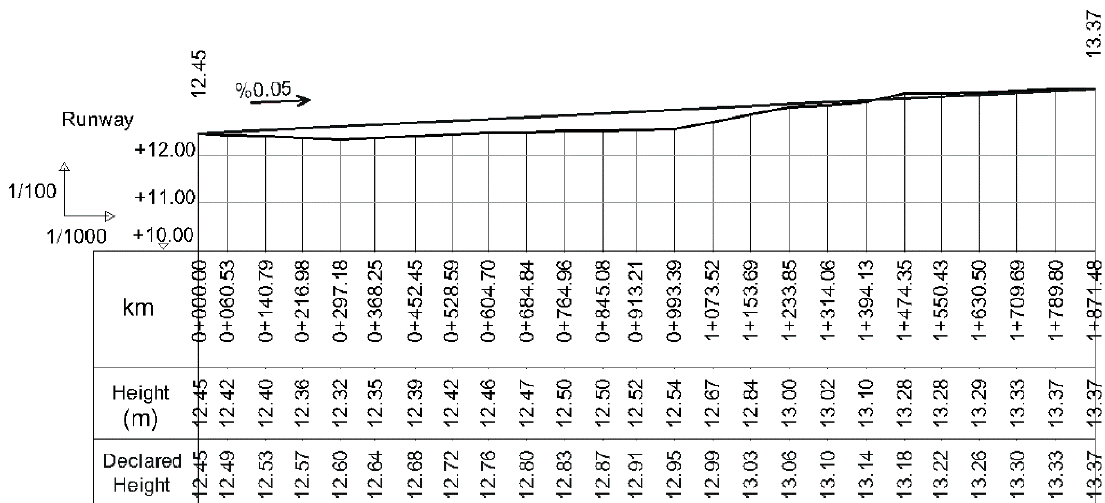
Table 2. Reference systems used in the investigated digital elevation models (DEMs).